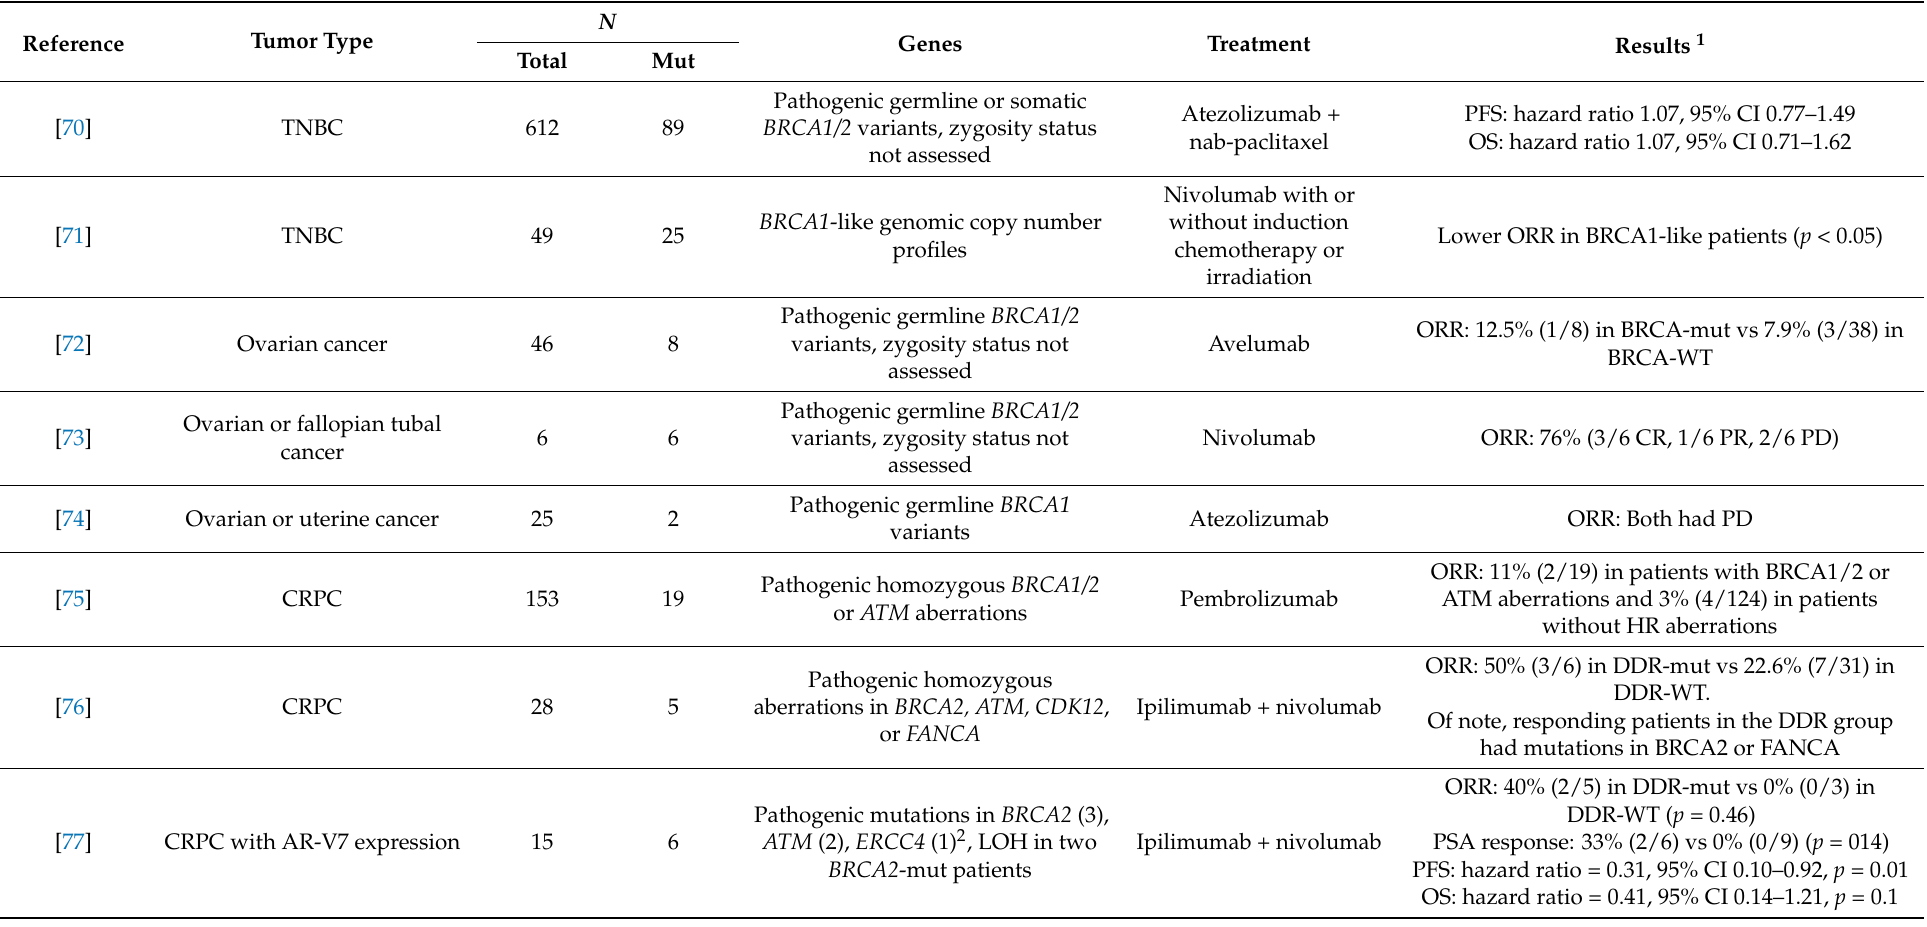
Table 1. The efficacy of checkpoint inhibitors in HRD